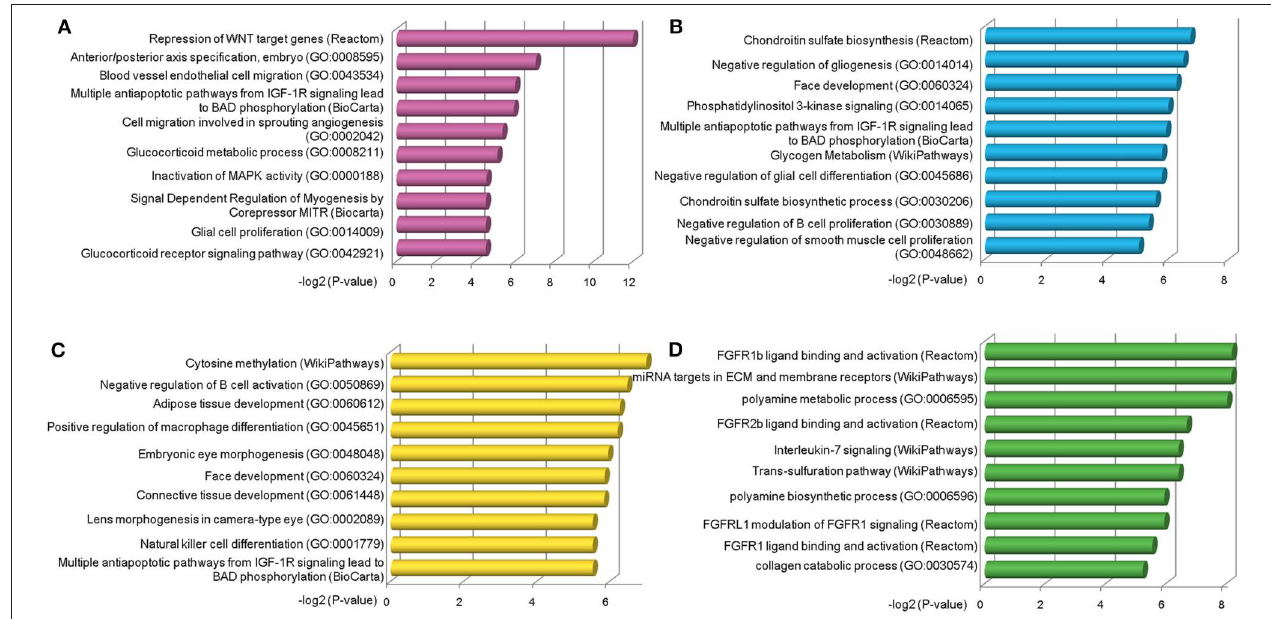
FIGURE 4 | Functional analysis of stage-specific TF-lncRNA regulatory groups. (A) Group a was found to be associated with Repression of WNT target genes and other OC-related pathways. (B) Group c was found to be associated with chondroitin sulfate biosynthesis pathway and process (GO:0030206). (C) A series of immune cell activation and differentiation processes were found in group d. (D) Group e was associated with FGFR ligand binding and activation